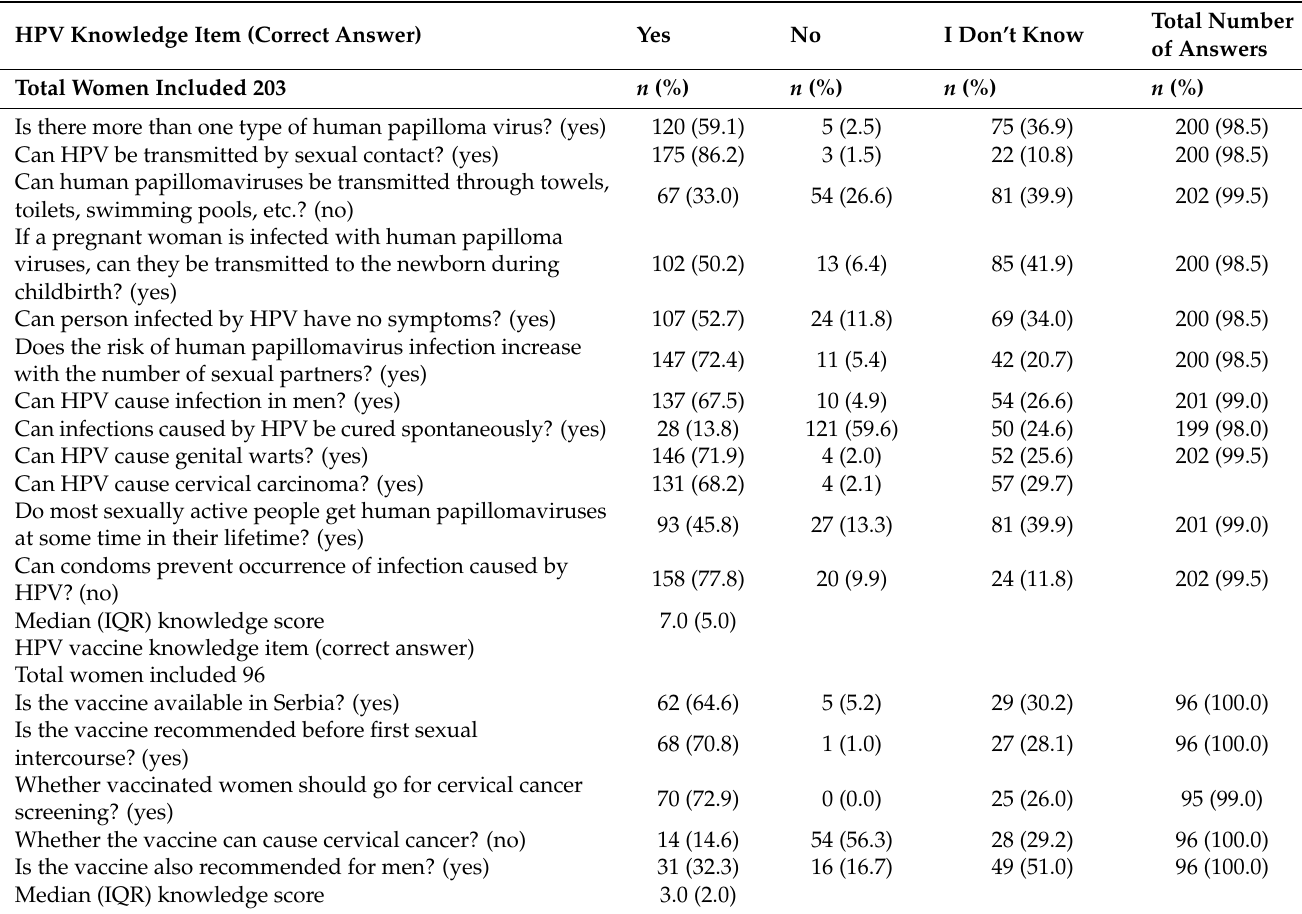
Table 3. HPV and HPV vaccine knowledge